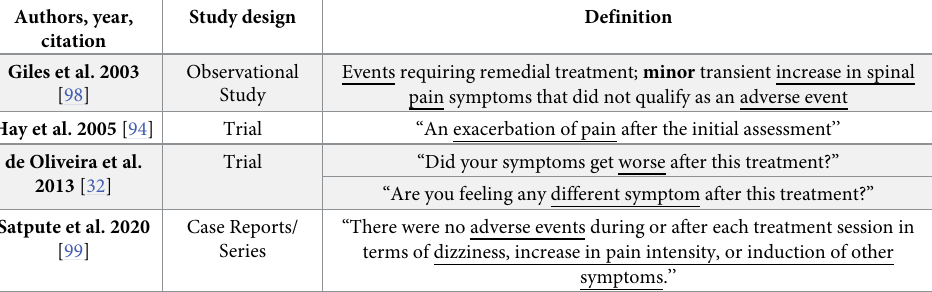
Table 6. Studies providing indirect adverse event definition only (n =